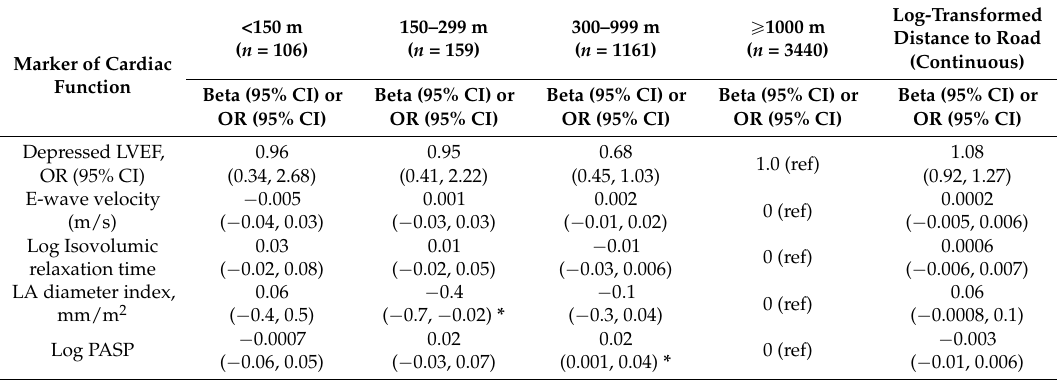
Log-Transformed Distance to Road